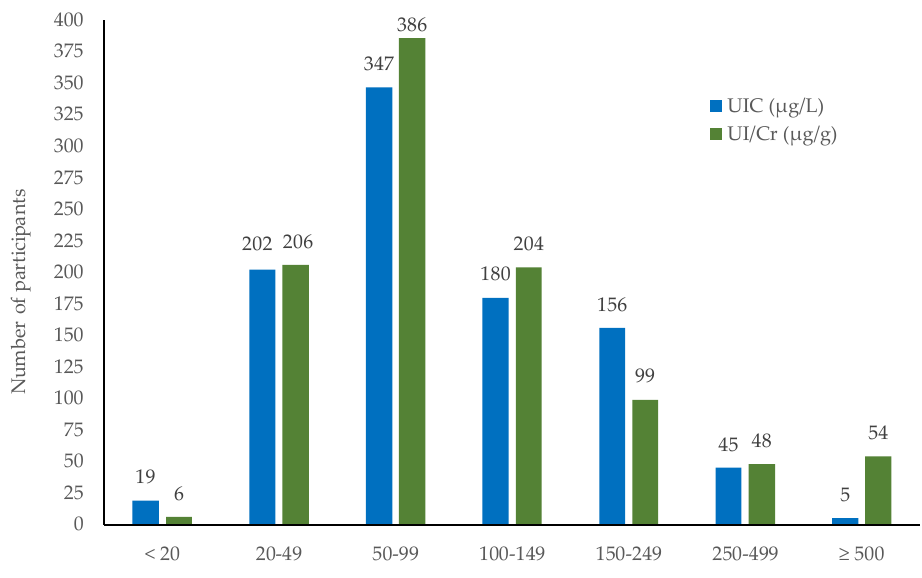
Figure 2. Distribution of spot urinary iodine concentration (UIC) (µg/L) (blue bars) and urinary iodine to creatinine ratio (UI/Cr) (µg/g) (green bars) in the study population ( n = 954) according to WHO epidemiological criteria [8].